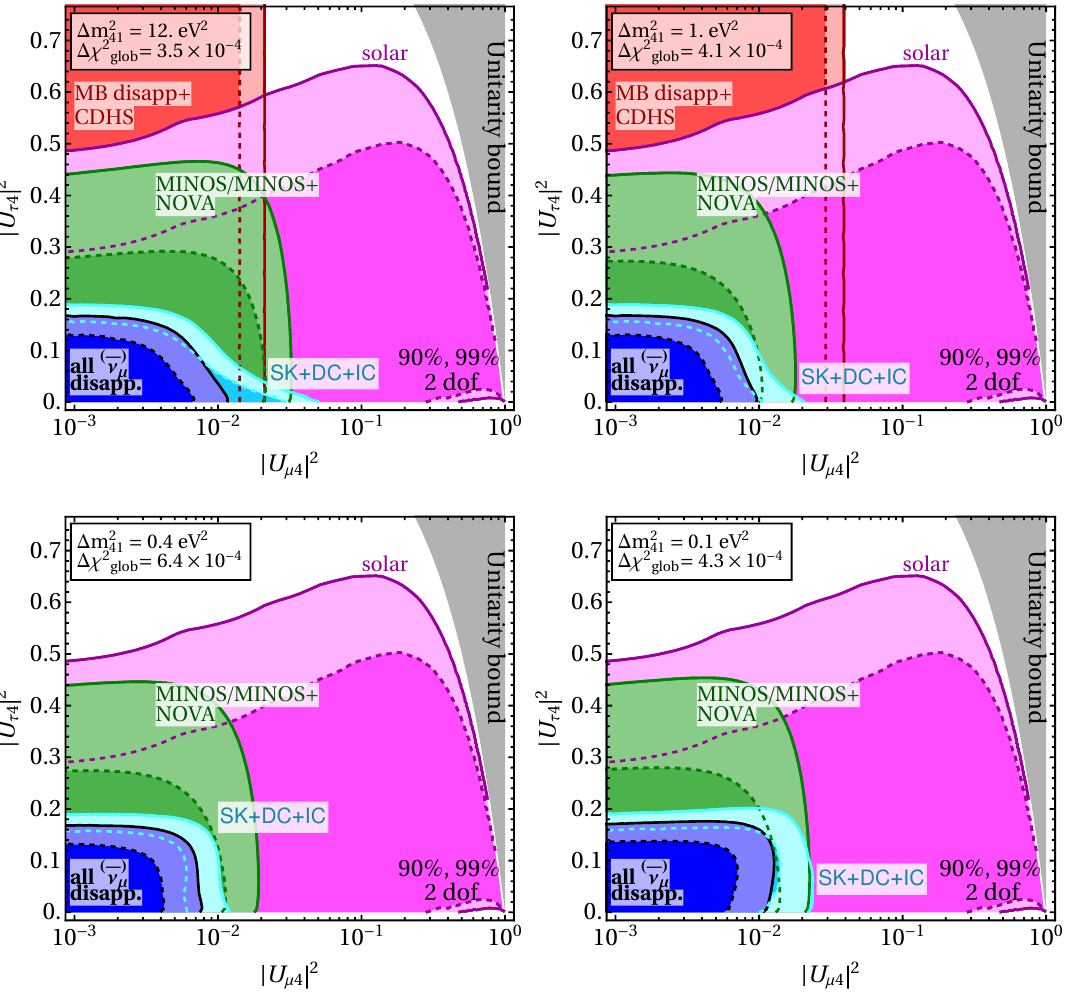
Figure 6 . Constraints on the mixing of sterile neutrinos with muon and tau neutrinos, parameter- ized by the corresponding elements j U (cid:22) 4 j and j U (cid:28) 4 j of the leptonic mixing matrix. In each panel, (cid:1) m 2 has been (cid:12)xed to a di(cid:11)erent value, while (cid:1) m 2 , (cid:18) 23 , (cid:18) 12 and (cid:18) 14 , as well as complex phases 41 31 have been pro(cid:12)led out in those experiments where they have a signi(cid:12)cant impact. Exclusion con- tours are drawn relative to the minimum (cid:31) 2 in each panel; the di(cid:11)erence to the global minimum (cid:31) 2 is indicated in each plot. Grayed out areas show the parameter region incompatible with the unitarity of the leptonic mixing